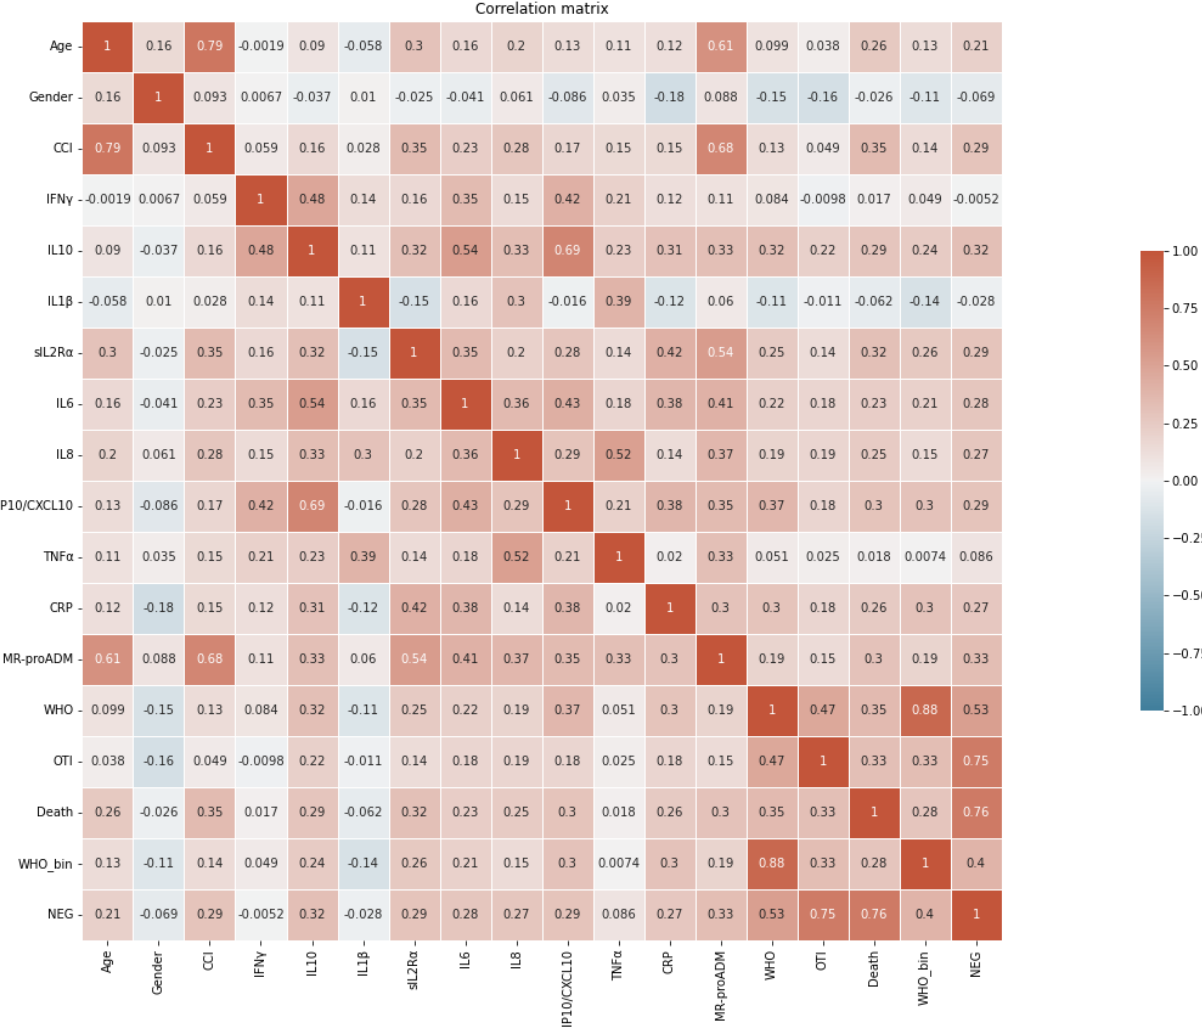
Figure 1. Correlation matrix. Heat map summarizing the results of Spearman correlation analysis among the demographic, clinical and cytokine data considered. Correlation coefficients (r) are shown in the relative boxes found at the intersection between the considered variables. Positive correlation coefficients are shown in shadows of red, while negative correlations in shadows of blue.